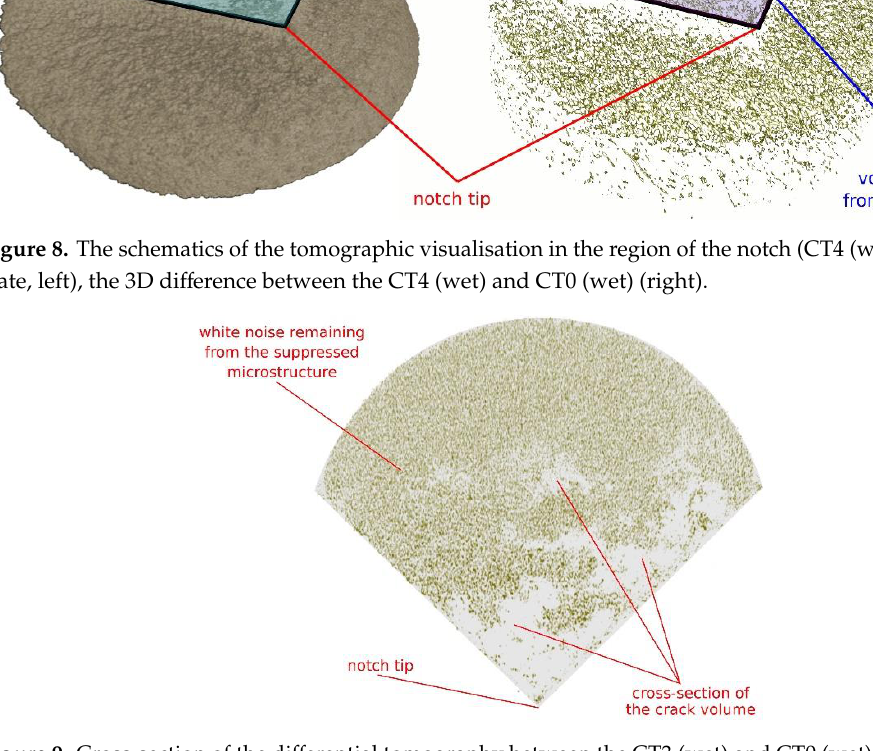
Figure 9. Cross-section of the differential tomography between the CT3 (wet) and CT0 (wet), smoothed by the floating average from eleven neighbouring slices. The crack is emphasized (grey regions), while the stone microstructure practically disappeared — only white noise remained.